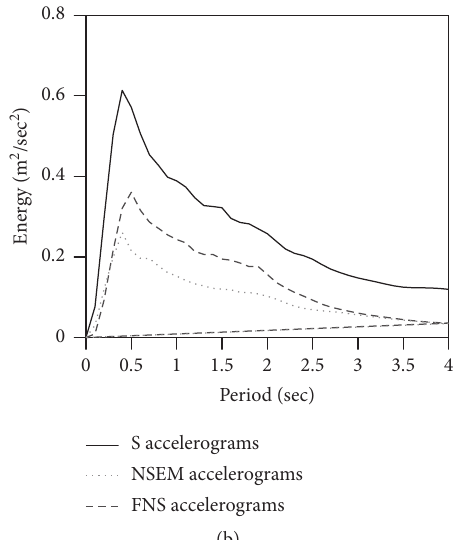
Figure 8: Energy spectra: (a) energy spectrum obtained from each accelerogram; (b) comparison between the mean energy spectra from each set of